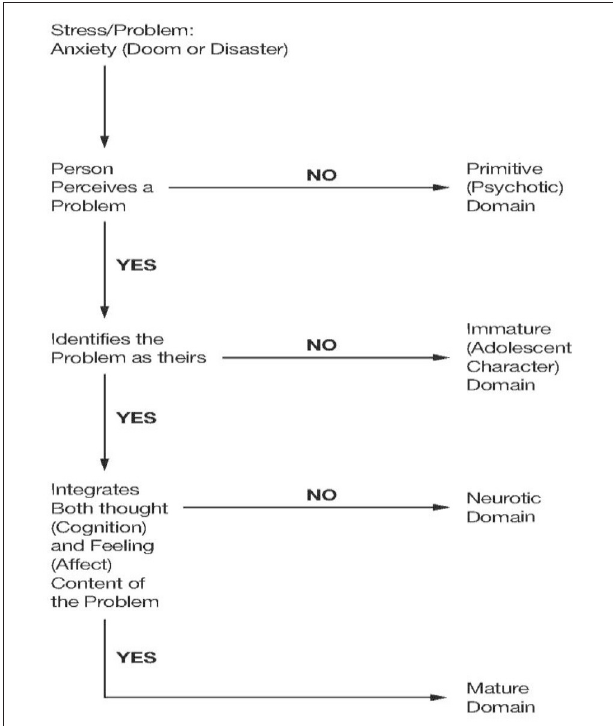
FIGURE 1 | Recognition algorithm for psychological adaptive mechanism domains. Source: Table 3.1 from Beresford (2012, p. 28). Reprinted with